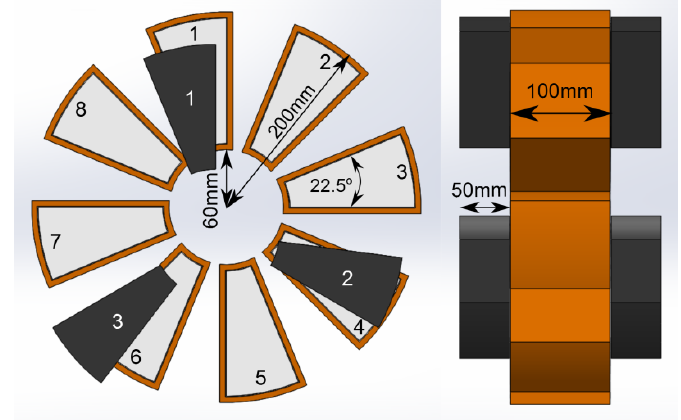
Figure 3. An example of a flux pattern in a single phase of an AFSRM.